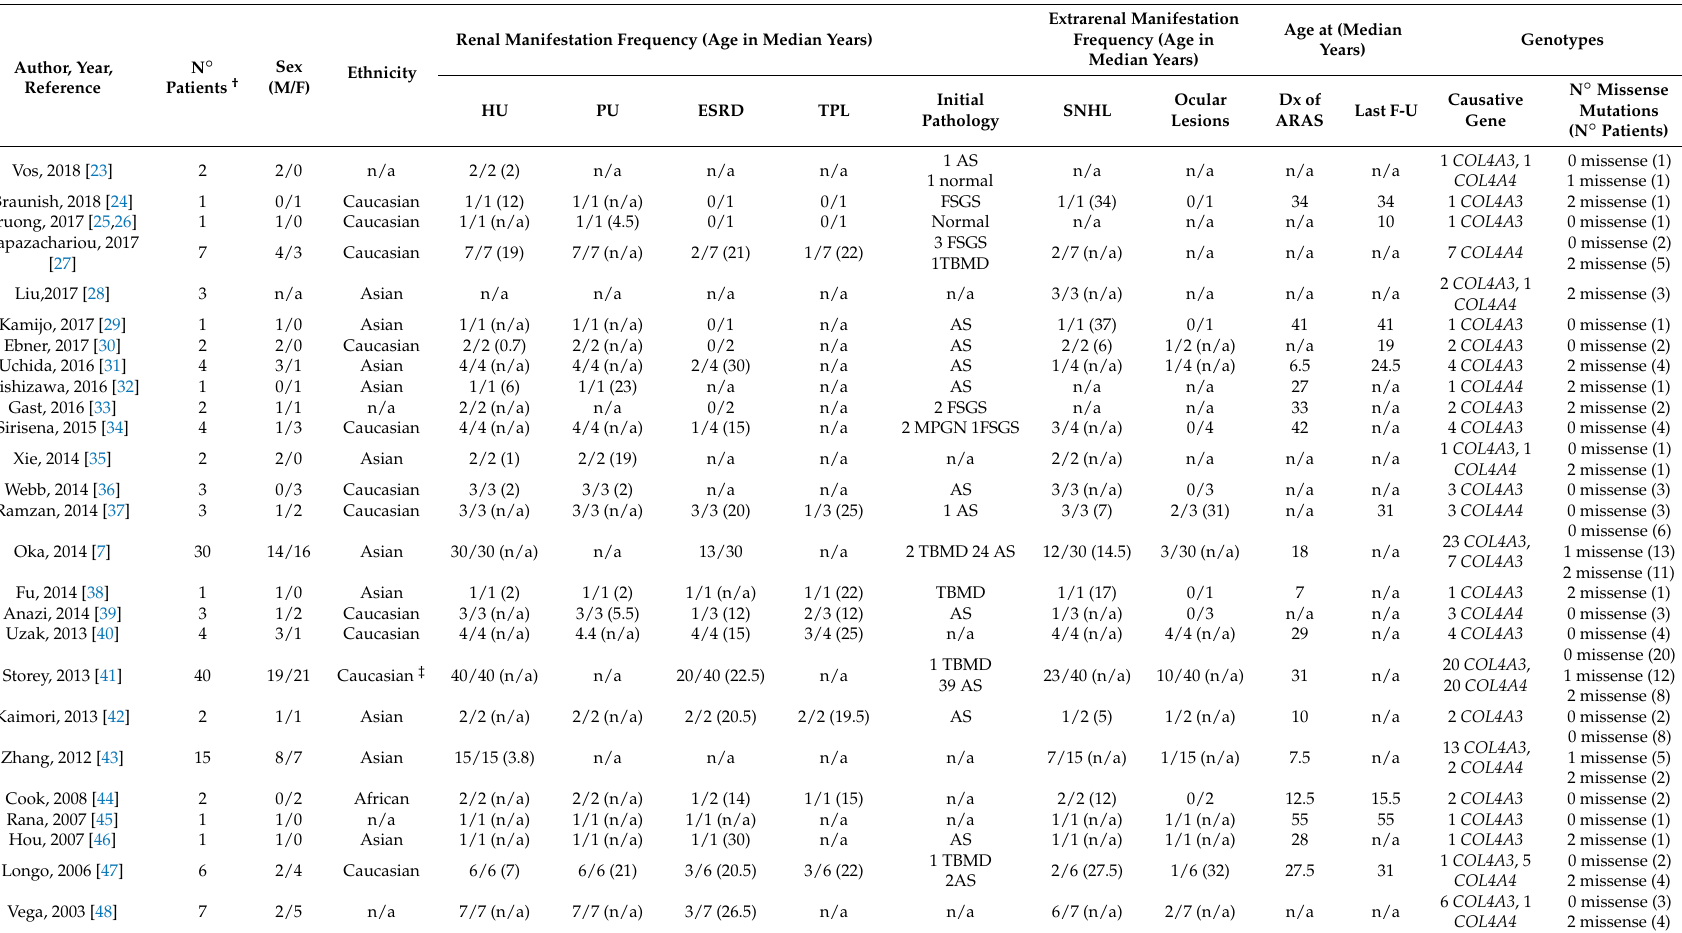
Table 1. Summary profiles of individual patient data with autosomal recessive Alport